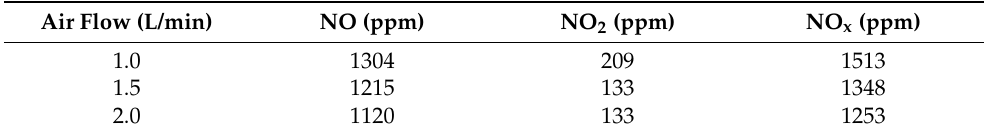
Table 2. The concentration of NO x in the exhaust gas.